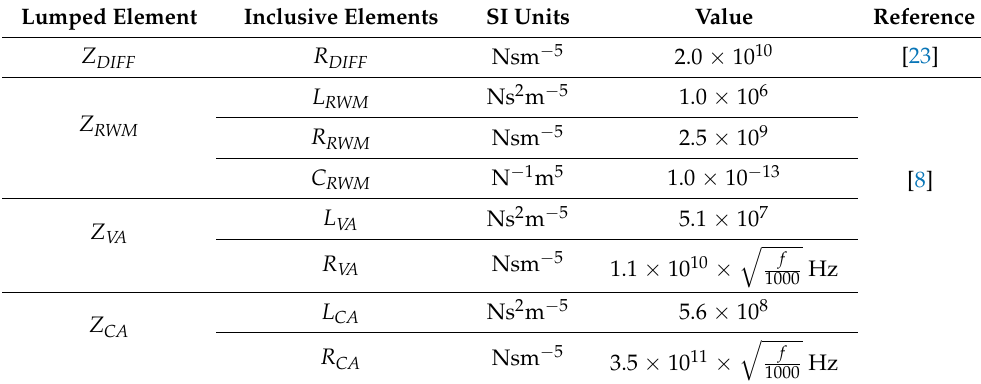
Table 2. Parameters and respective values used in Elliot et al.’s LEM.